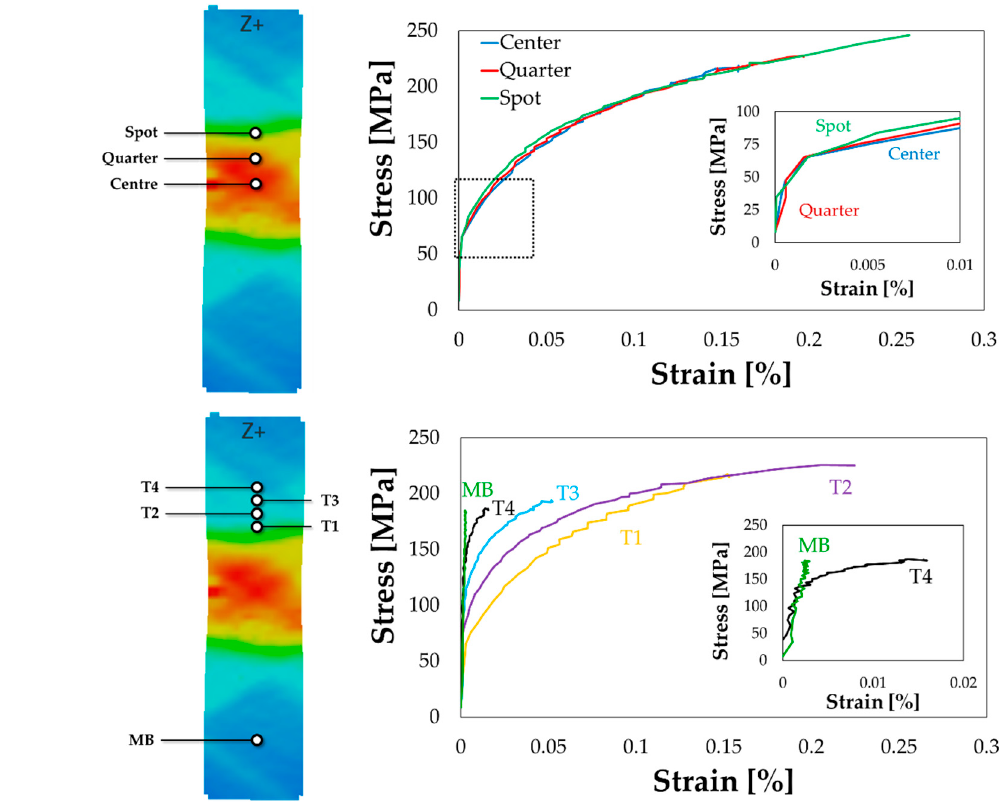
Figure 10. Uniaxial tensile test on the LHT specimen: flow curves from ( a ) the irradiated portion and ( b ) from the transition region and base material.